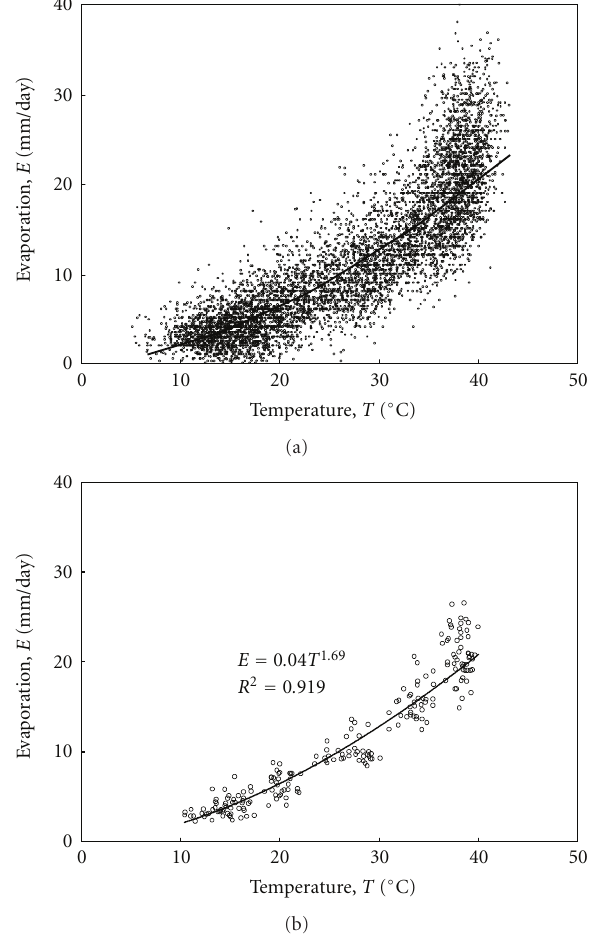
Figure 2: Evaporation as a function of temperature for the data of Kuwait from 1993 to 2009. The solid curves represent suggested relations fitted using regression analysis. (a) Daily average data; (b) monthly average